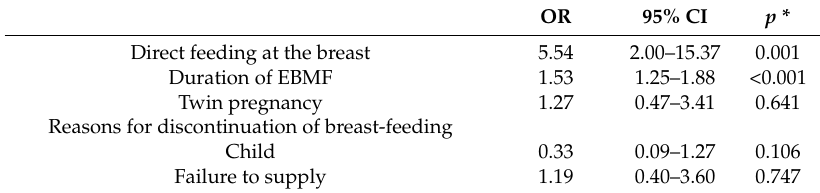
Table 3. Results of logistic regression analysis predicting BMF > 6 months.